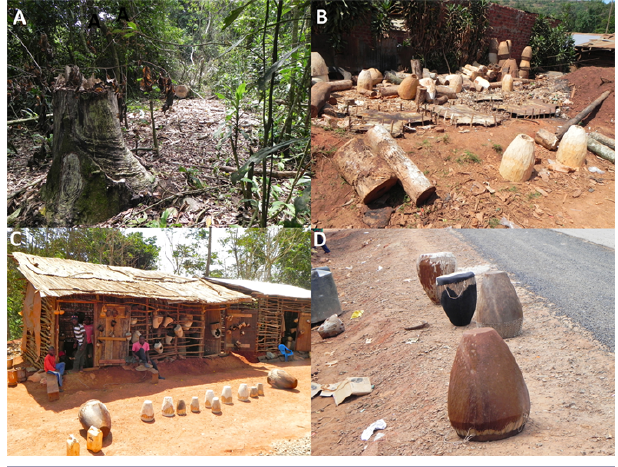
Fig. 2. Stages of drum making in Mpanga Central Forest Reserve near Mpigi, Uganda. (A) Felling of trees (which is contrary to forest regulations), resulting in a large stump (foreground), and a fallen log (background). Most of this tree has been cut up and chipped out to make blank drums. (B) A drum-making yard showing sectioned logs used as raw material (foreground) and drums in various stages of manufacture (background). (C) Finished drums and other handicrafts for sale in roadside stalls. (D) Close-up view of finished drums.